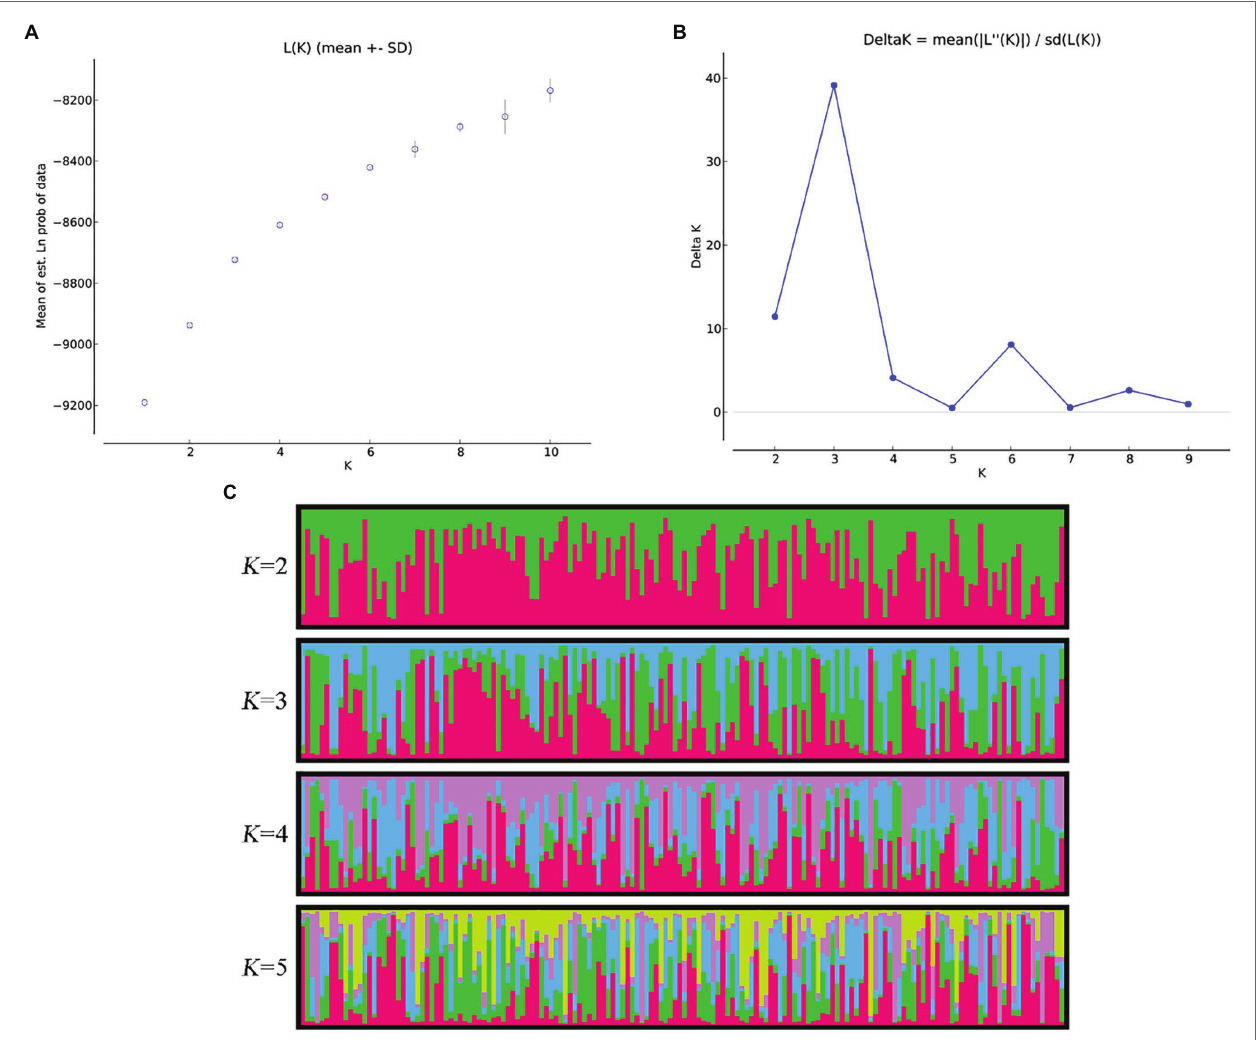
FIGURE 1 | Estimation of genetic structure of 160 accessions using 38 simple repeat sequences (SSRs) based on the STRUCTURE. (A) Log probability data [Ln P ( D )] for each K value (10 replicates). (B) Δ K estimates of the posterior probability distribution of the data for a given K . (C) Estimated population structure and clustering of 160 accessions with K = 2–5. Accessions are shown by thin vertical